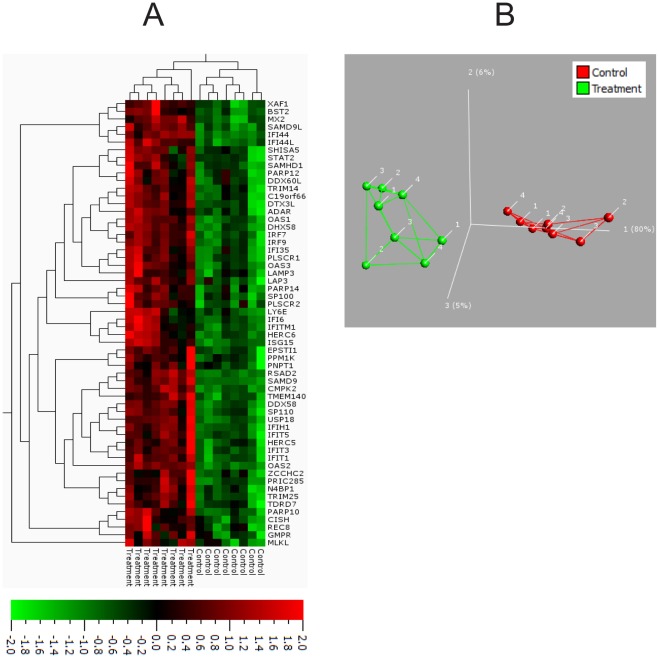
Clustering and PCA analysis of differentially expressed genes after prolactin treatment in parathyroid adenoma cells.A) Heat map of hierarchical clustering show 58 changed genes (adjusted P<0.01) as detected by Qlucore analysis. B) PCA of the gene expression data in a 2D graph, plotting individual primary cultures of parathyroid adenomas. Colours indicate either; green = control or red = prolactin treated. Numbers indicate individual cases. For significant genes (adjusted P<0.01), samples were grouped according to treatment. Lines indicate the three closest relationships to a sample.